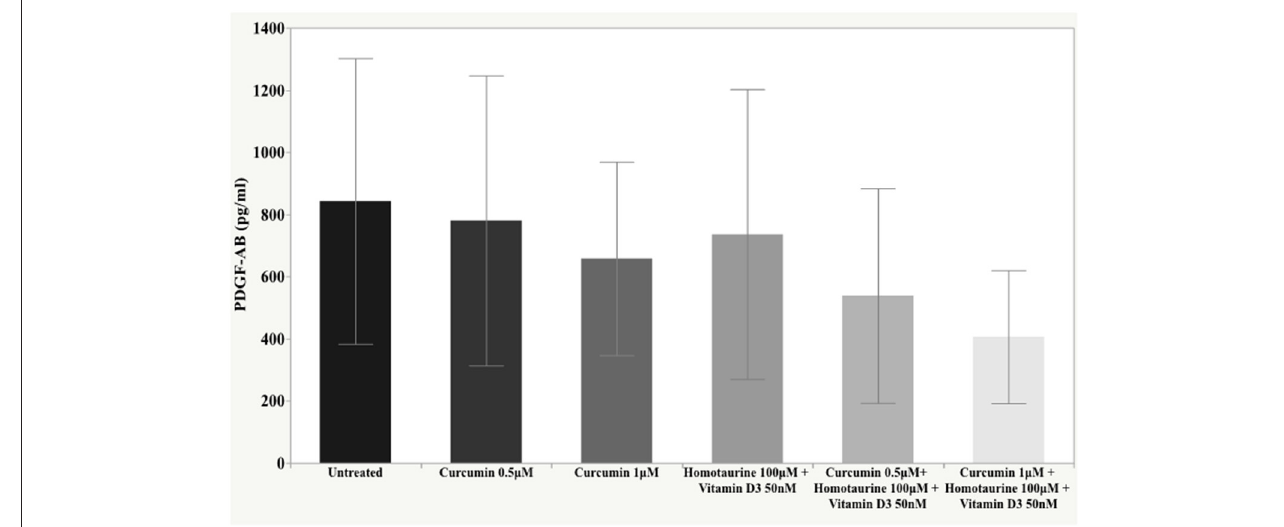
FIGURE 3 | Histogram of the mean and standard deviations of PDGF-AB by experimental groups.